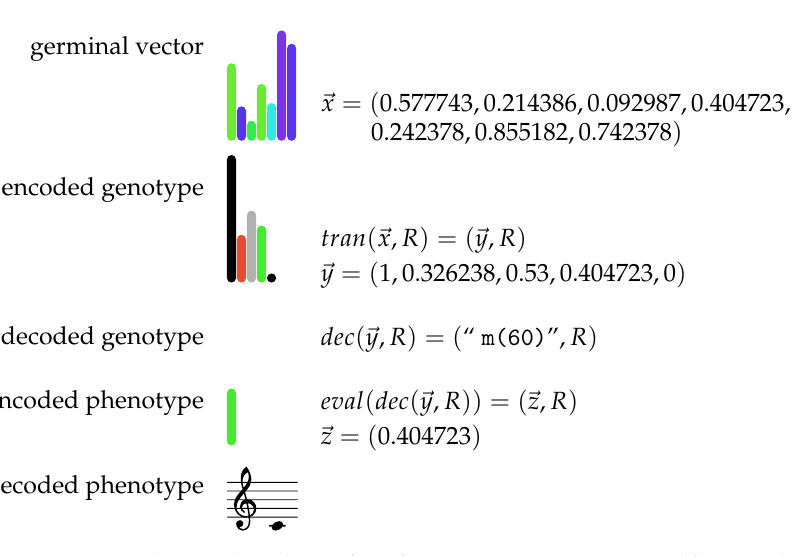
Figure 8. Minimal example with a midipitch parameter representing middle C. Each value in germinal vector (cid:126) x is mapped to corresponding values in encoded genotype (cid:126) y following the rules described in Figure 6. Note that the last two values of (cid:126) x are ignored because they are not